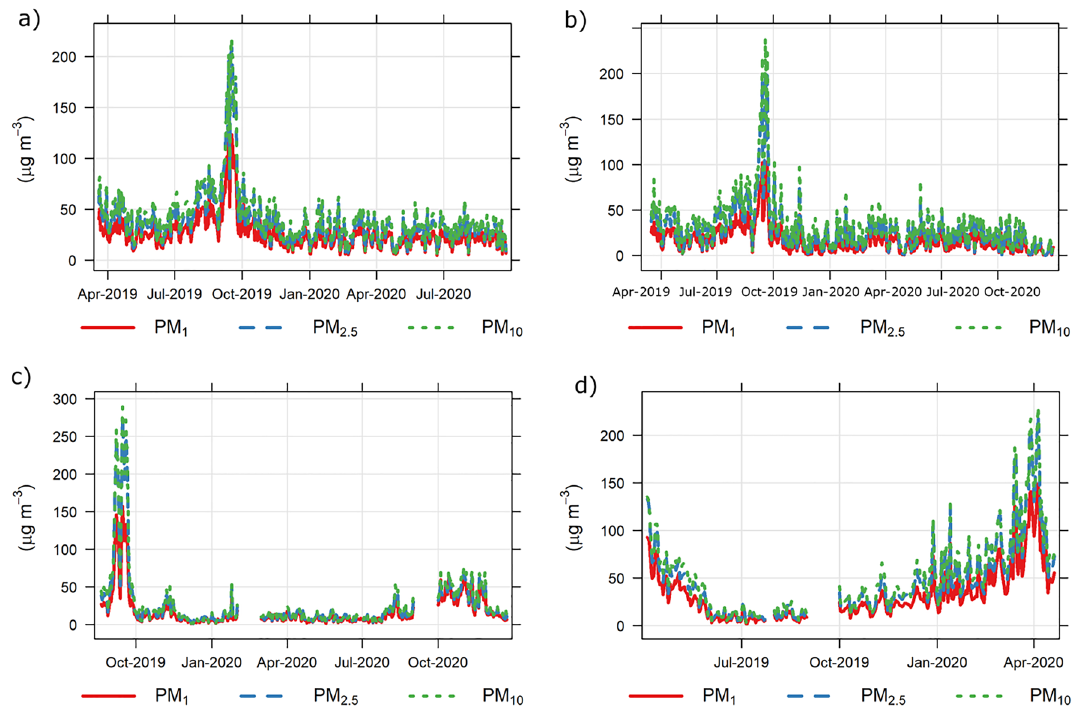
Figure 1. Daily average concentration of PM 10 , PM 2.5 and PM 1 in ( a ) Putrajaya, ( b ) Bukit Fraser, ( c ) Kota Samarahan and ( d ) Chiang Mai.